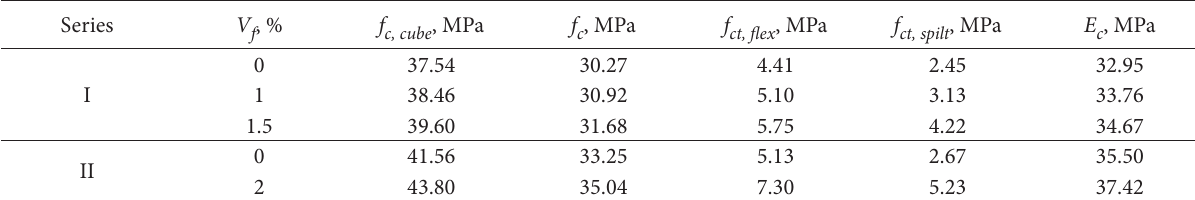
Table 3. Concrete strength characteristics